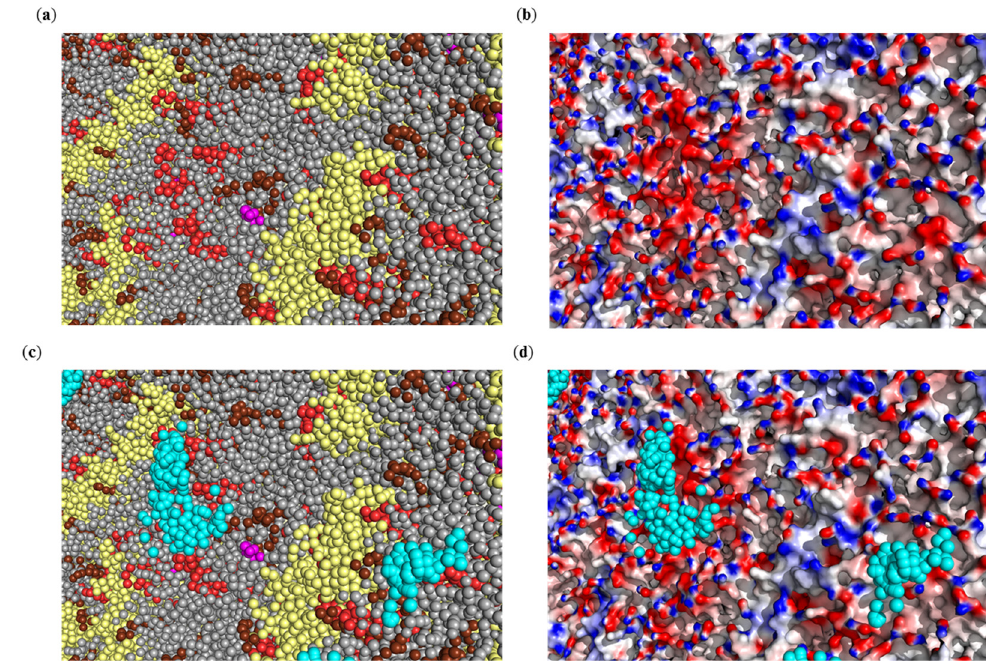
Figure 2. A fragment of the envelope of the SARS-CoV-2 virus, with M proteins and patches of charged lipids, which is an enlarged view of the rectangular area highlighted in green in Figure 1a ( a ). Molecular surface distribution of electrostatic potential from − 100 mV (red) to +100 mV (blue) ( b ). Positions of the Zn atom in electrostatic encounter complexes of ZnPcChol 8+ with SARS-CoV-2 virion obtained by BD ( c , d ). Virus envelope is colored in accordance with component types ( c ) and electrostatic potential ( d ). Neutral lipids, namely POPC, POPE, and CHOL, are shown as gray spheres; POPI molecules—as brown spheres; POPS—as magenta spheres; CDL2—as red spheres. Positions of the Zn atom of ZnPcChol 8+ are shown as cyan spheres.